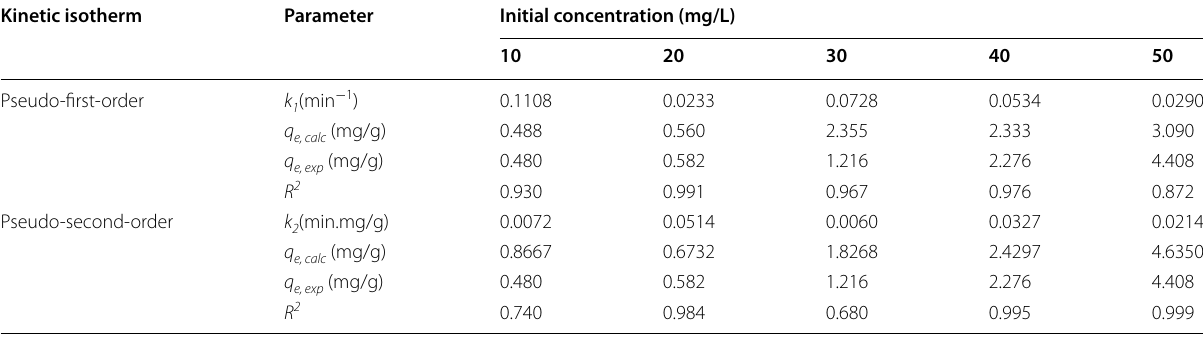
Table 4 Adsorption rate constants and parameters of Cu (II) ion adsorption from the pseudo-first-order and pseudo-second-order kinetic models Kinetic